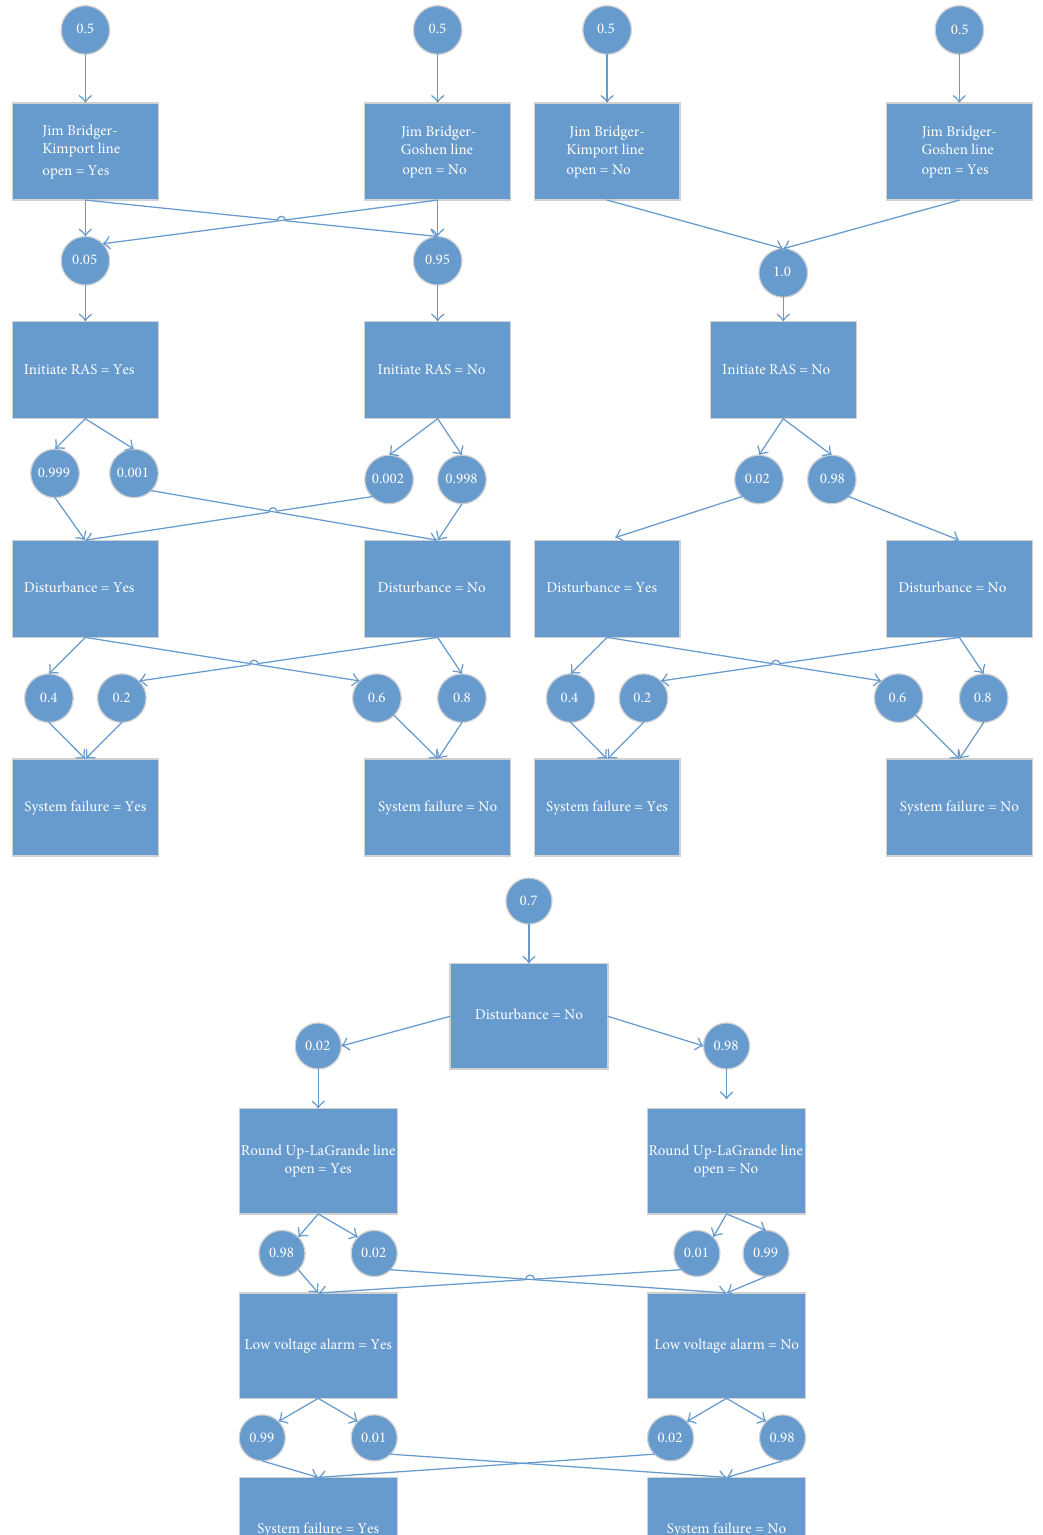
Figure 4: US blackout three-event